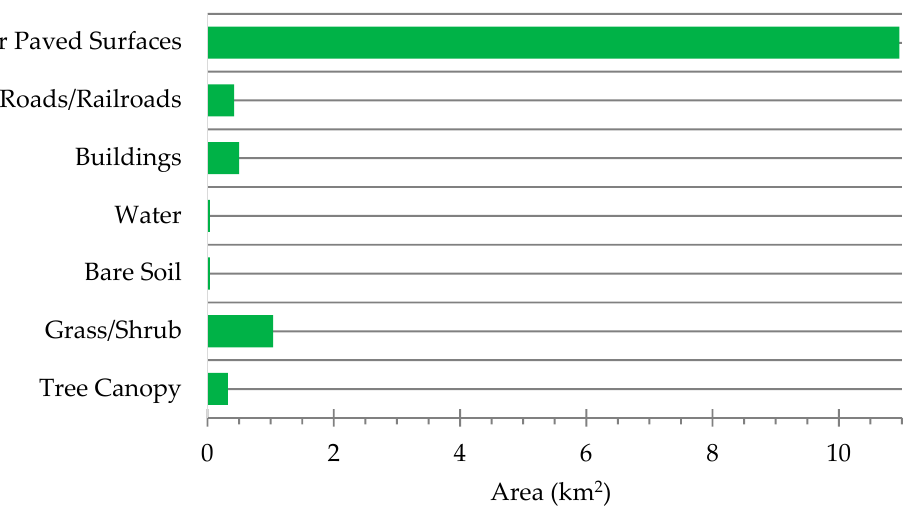
Figure 7. Contributions to the increase in GI by area (km 2 ) from 2008 to 2036.